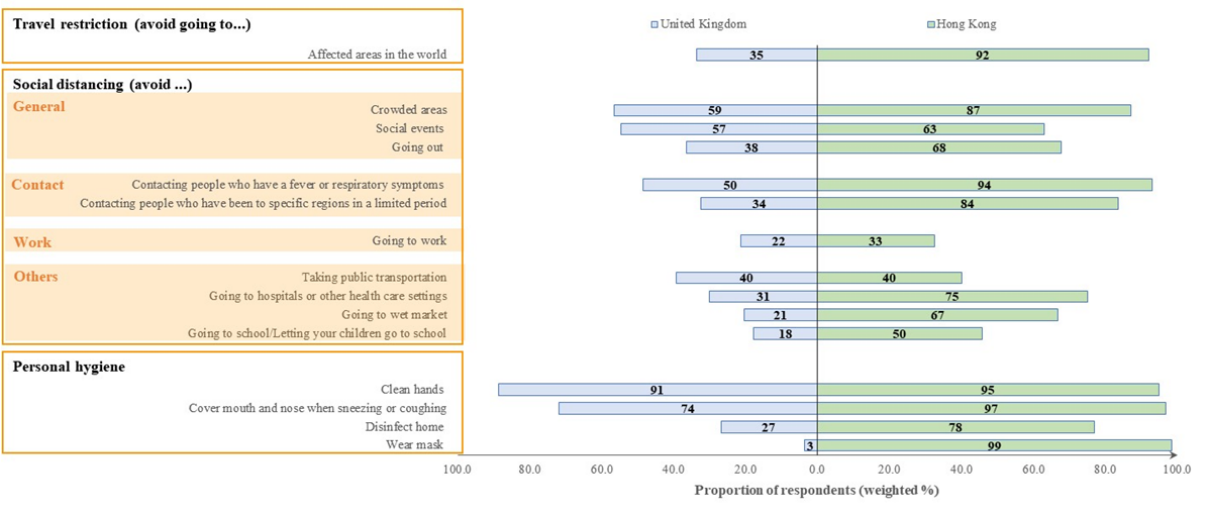
Figure 1. Adoption of precautionary measures against COVID-19. “Affected areas” refers to China (Hong Kong)/affected areas in the world (United Kingdom); “Specific regions in a limited period” refers to Wuhan in the past one month (Hong Kong)/affected areas in the past 14 days (United Kingdom). The “Going to work” category only included respondents who were employees or employers (n=2160), and the “Going to school/letting your children go to school” category only included respondents who were full-time students or had at least one child (n=1239).